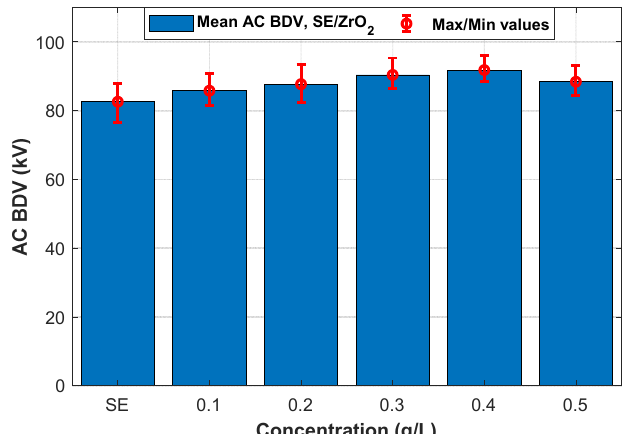
Figure 7. Mean breakdown voltages of synthetic ester and synthetic ester-based ZnO (25 nm) nanofluids at different concentrations.